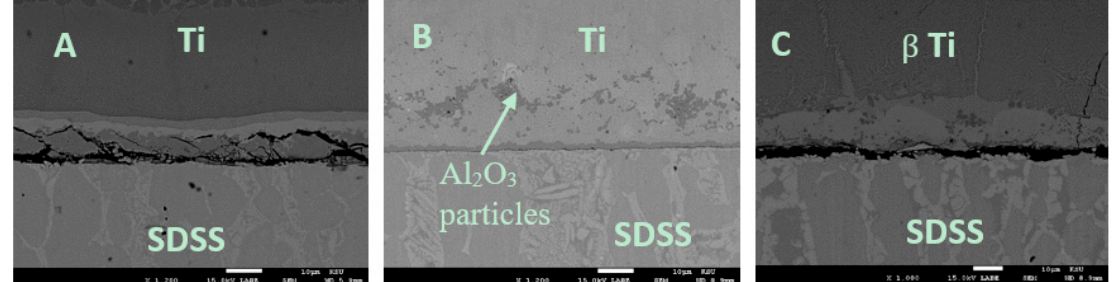
Figure 4. SEM micrograph of Ti–6Al–4V and super-duplex stainless steel diffusion bonded for 30 min using a Cu/Al 2 O 3 interlayer at the following temperatures: ( A ) 800 °C, ( B ) 850 °C, ( C ) 900 °C.